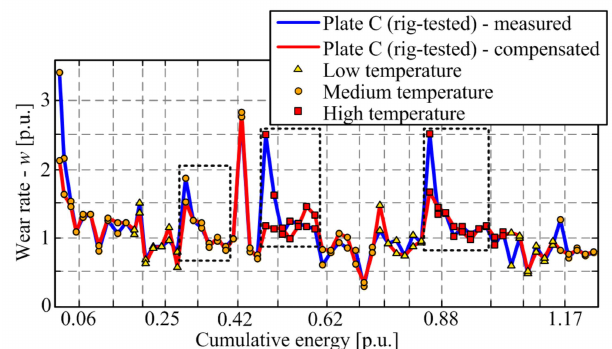
Figure 10. Comparison of moisture content compensated and uncompensated wear rate response for the rig-tested friction plate.